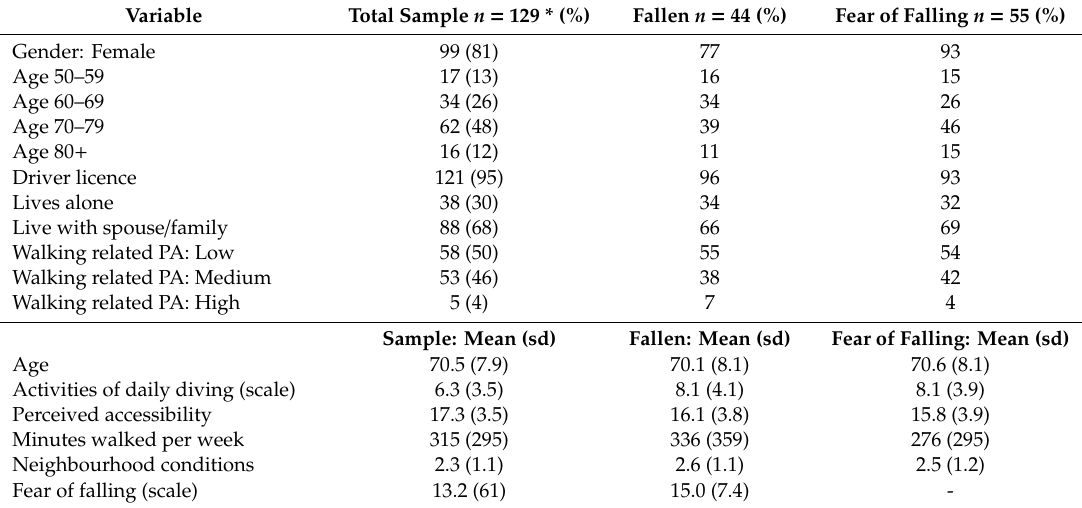
Table 1. Sample characteristics